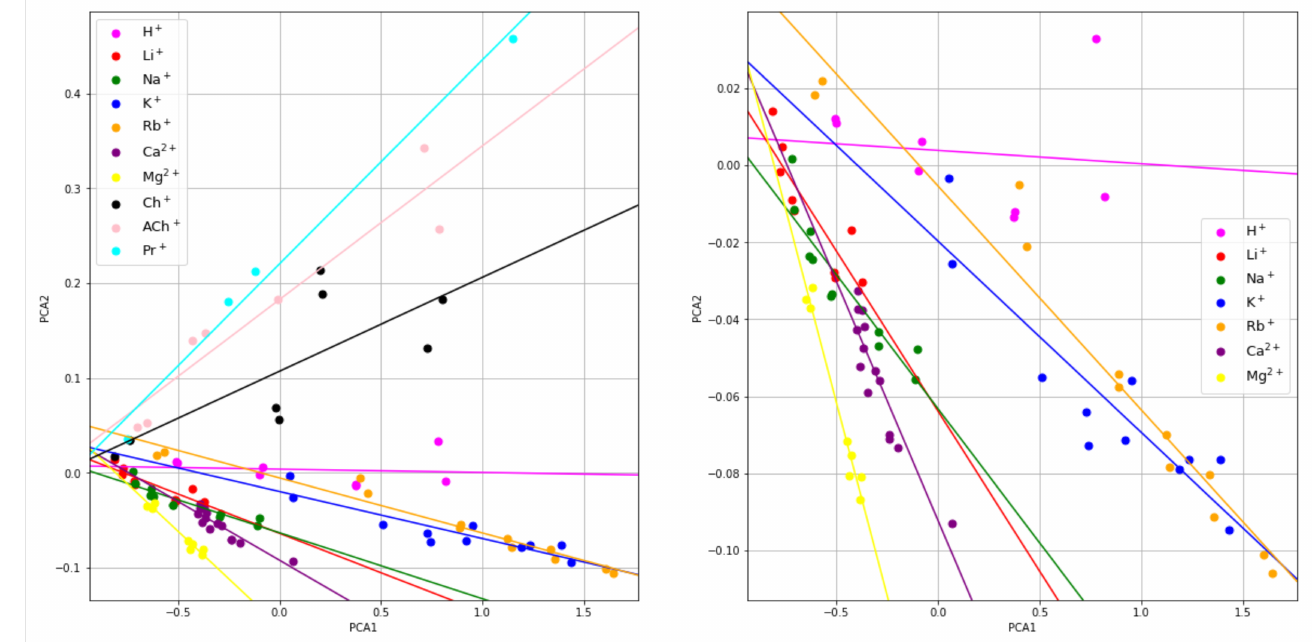
Figure 2. PC2 vs. PC1 maps. Global ( left ) and extended low zone, only inorganic cations ( right